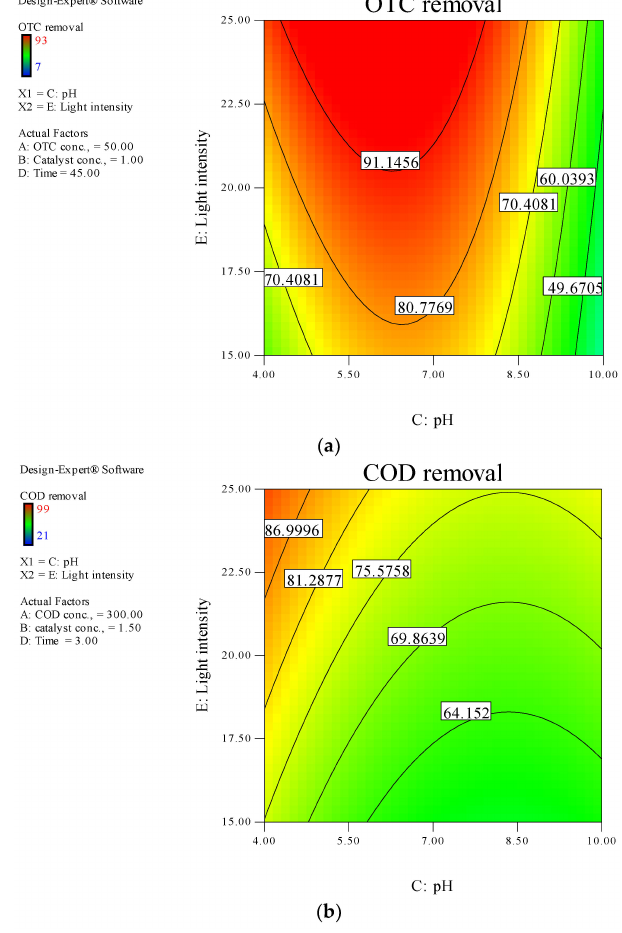
Figure 9. Contour plot of ( a ) OTC and ( b ) COD removal efficiency as a function of PH and light intensity. The effect of light intensity on the photodegradation efficiency are depicted in Figure